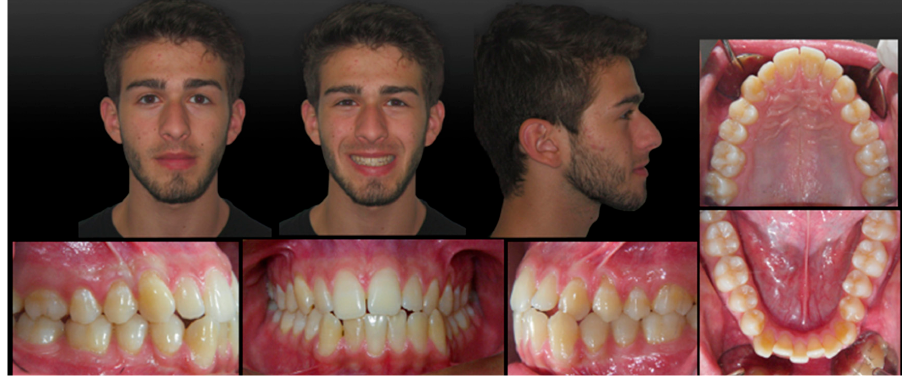
Figure 1. Pretreatment extra- and intra-oral records.